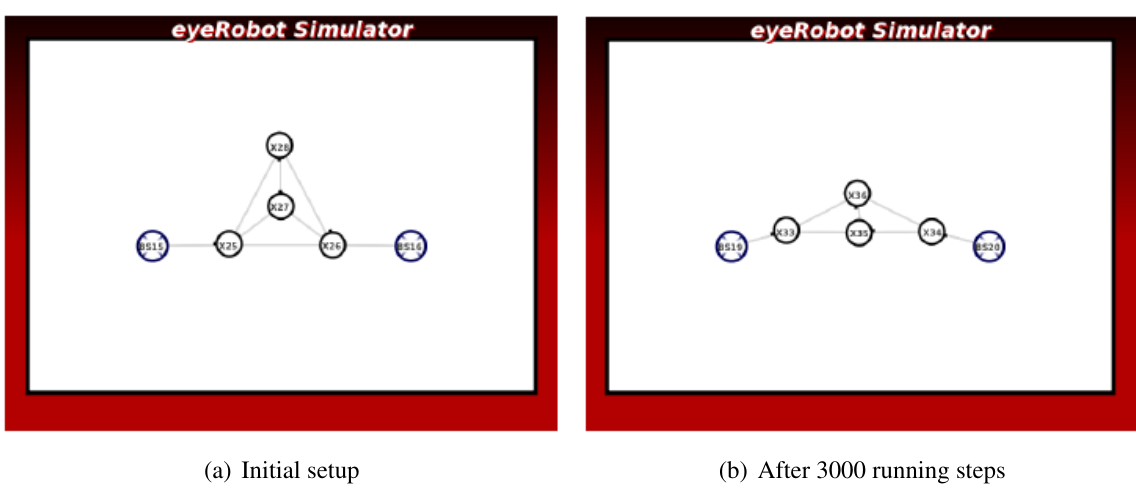
Figure 13. The experiment of the Trapped